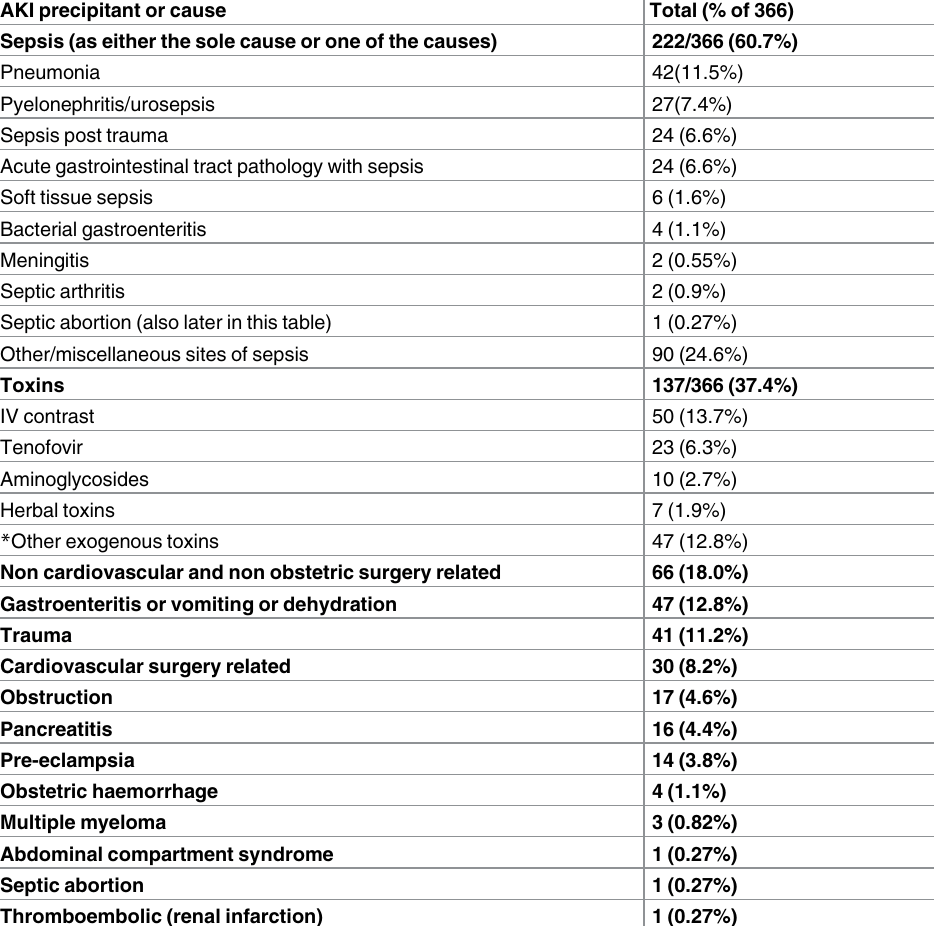
Table 1. Precipitants and causes of